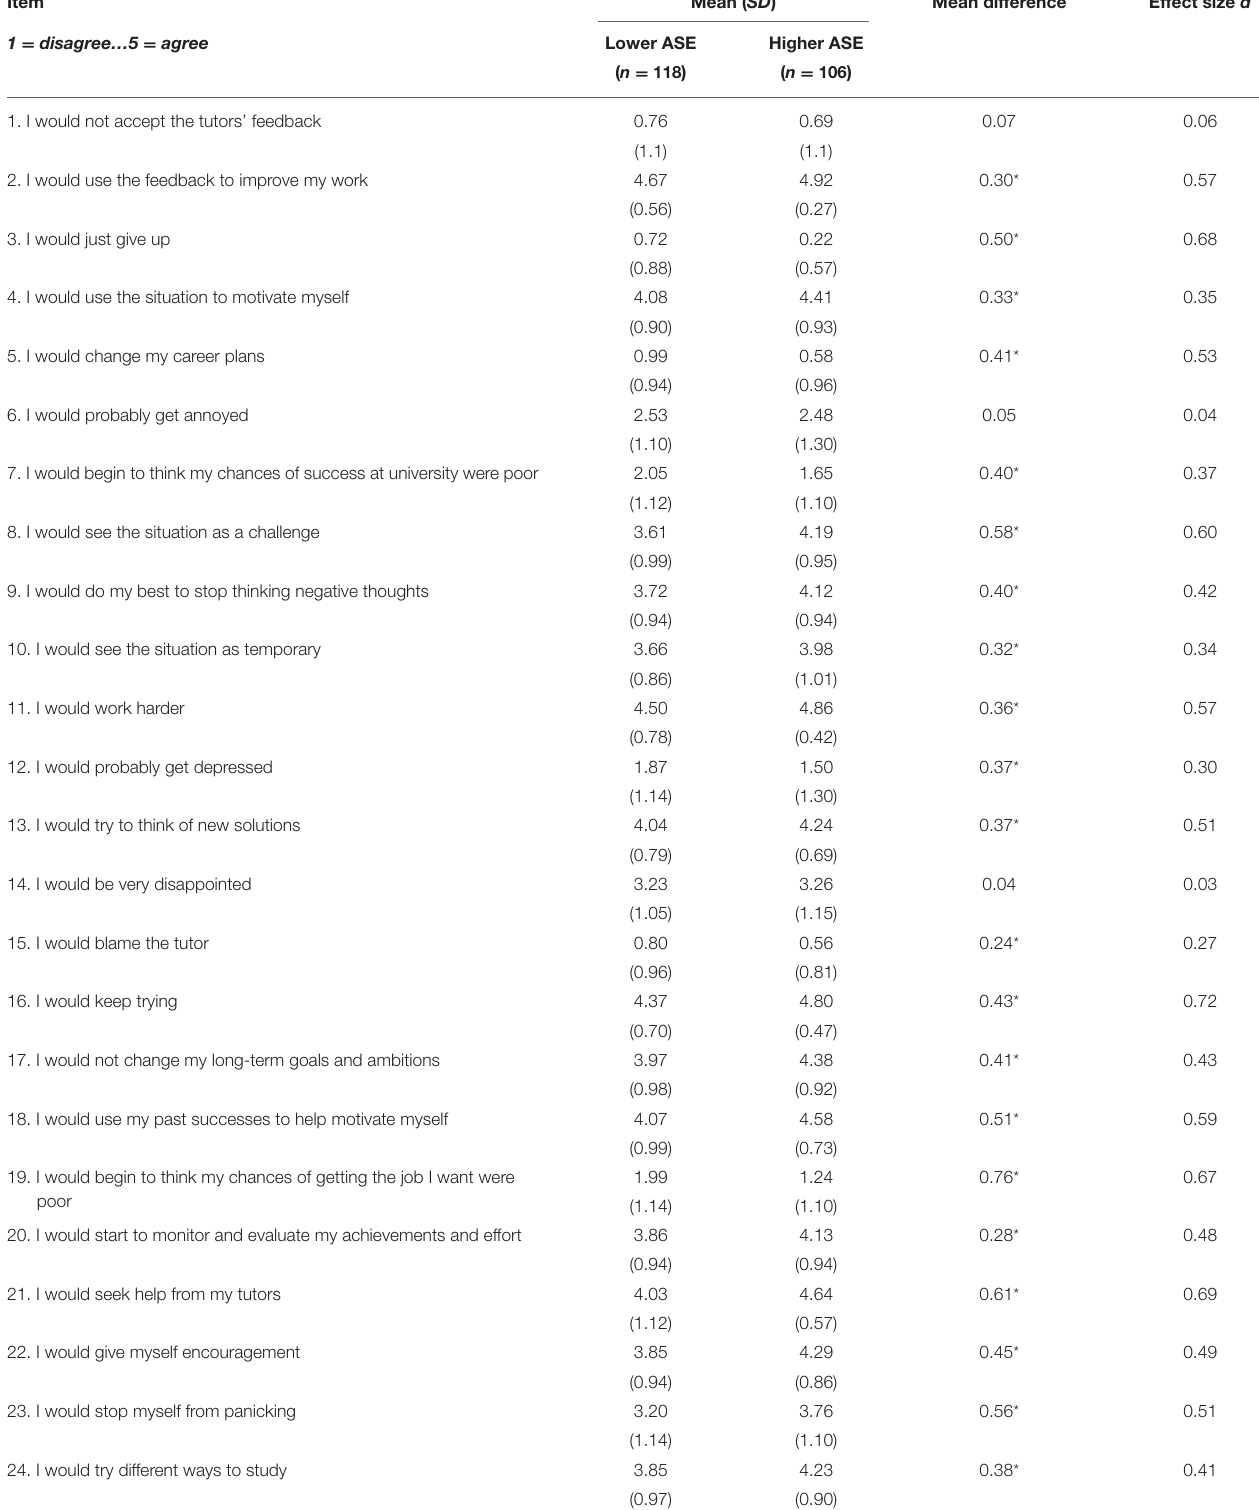
TABLE 5 | Academic resilience scale (personal vignette) item summary statistics by academic self-efficacy (ASE) group. Item Mean ( SD ) Mean difference Effect size